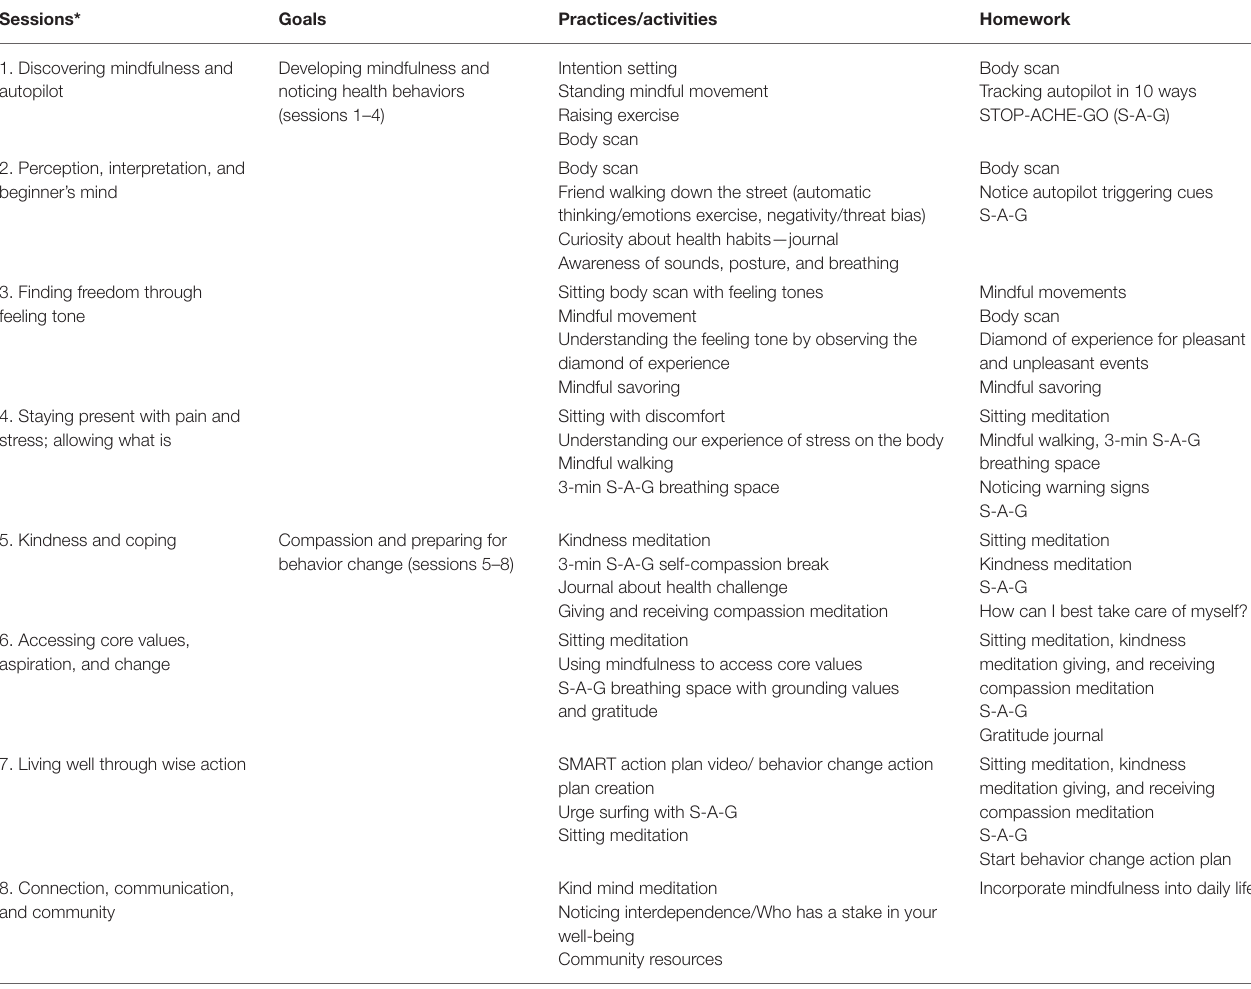
TABLE 1 | Mindfulness training for primary care (MTPC) core curriculum